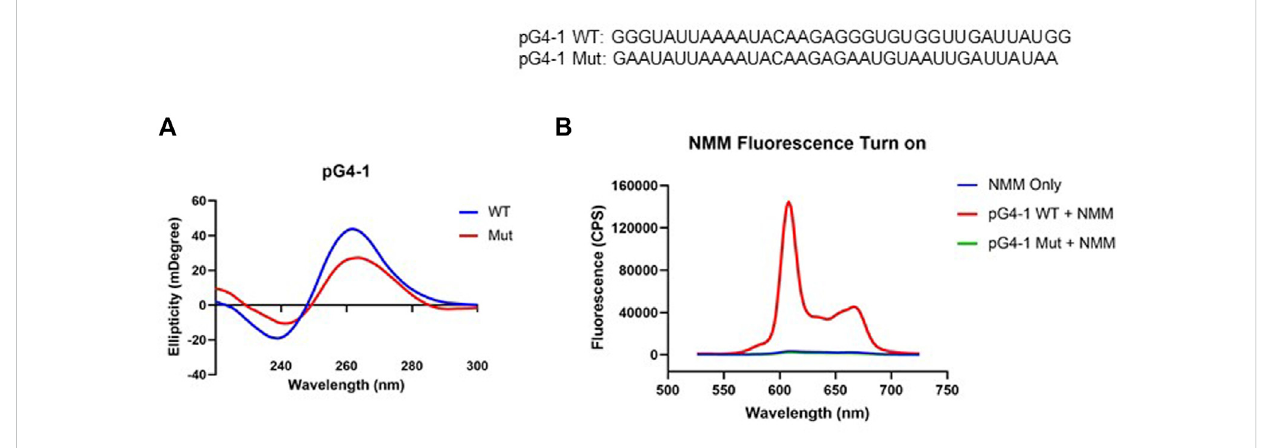
FIGURE 2 pG4-1 can form a G4 structure. (A) CD spectra of 5 μ M of pG4-1 WT and its mutated control, pG4-1 Mut where speci fi c ‘ G ’ s were mutated to ‘ A ’ s to prevent G4 formation. (B) Fluorescence spectra of 1 μ M NMM only or in presence of 1 μ M pG4-1 WT or pG4-1